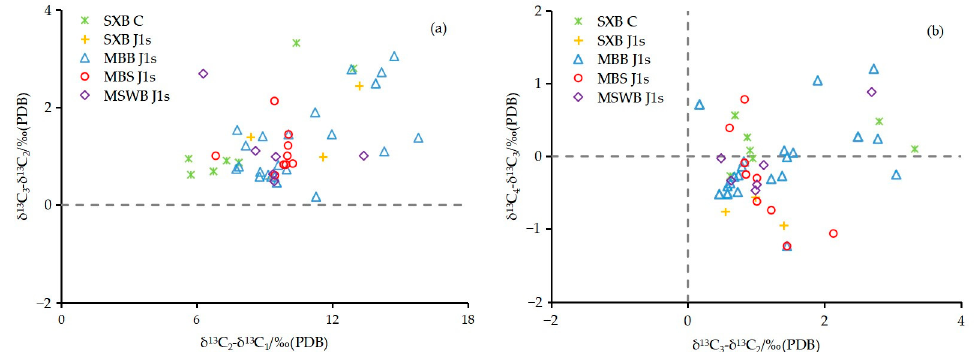
Figure 3. Cross-plots of δ 13 C 2 - δ 13 C 1 vs. δ 13 C 3 - δ 13 C 2 ( a ) and δ 13 C 3 - δ 13 C 2 vs. δ 13 C 4 - δ 13 C 3 ( b ) of the natural gas in the eastern belt around the Penyijingxi sag, Junggar Basin. SXB C means the Carboniferous system of Shixi bulge, SXB J1s means Jurassic Sangonghe formation of Shixi bulge, MBB J1s means Jurassic Sangonghe formation of Mobei bulge, MBS J1s means Jurassic Sangonghe formation of Mobei slope, MSWB J1s means Jurassic Sangonghe formation of Mosuowan bulge.